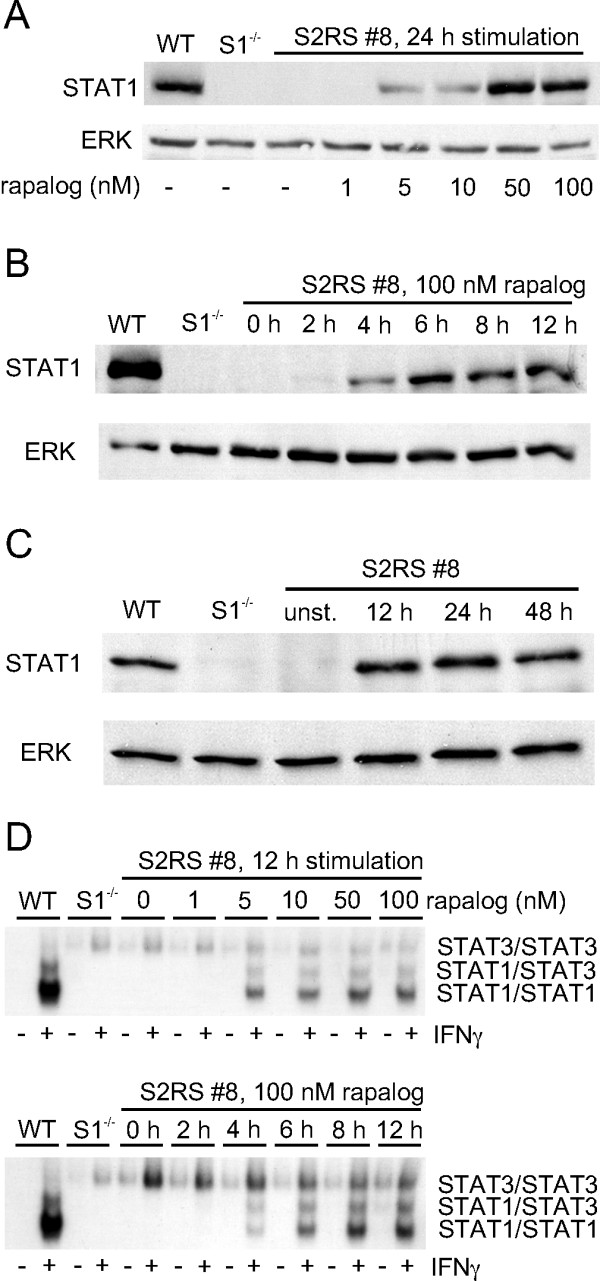
Inducible STAT1 expression in stably transfected MEF cell lines. WT, STAT1-/- (S1-/-) and STAT1-/- cells reconstituted with inducible STAT1 (S2RS #8) were treated with rapalog at the dose indicated for 24 h (A) or treated with 100 nM rapalog for the times indicated (B). To analyze STAT1 protein stability, cells were treated with 100 nM rapalog for 12 h, washed three times with PBS and further incubated without inducer. STAT1 protein expression was determined with WB analysis and loading was controlled via probing for ERK protein (A-C). Cells were treated as in A and B, stimulated with 100 U/ml IFNγ for 15 min or left untreated, lysed and 15 μg total cell extract subjected to EMSA analysis using hSIE oligonucleotides as probes (D). Similar results were obtained with other reconstituted clones.